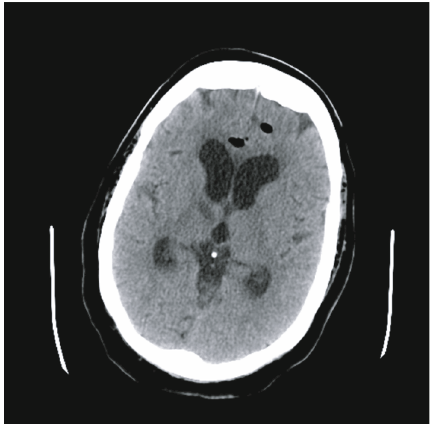
Figure 2: Brain CT demonstrating hydrocephalus and